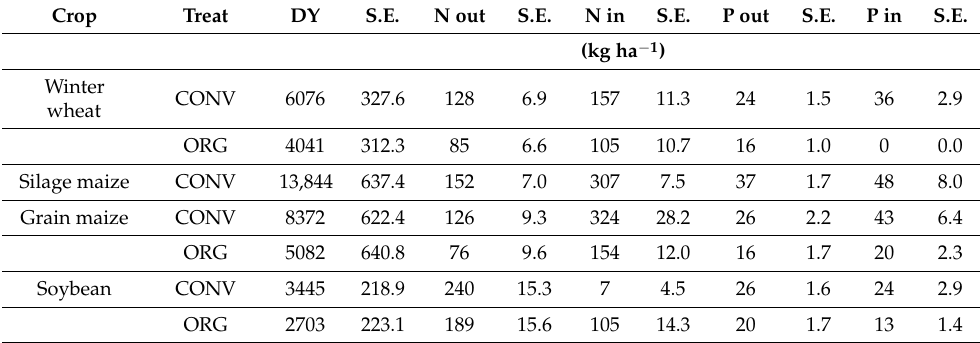
Table A2. Mean value of dry yield (DY), N output (N out), N input (N in), P output (P out), and P input (P in) according to crop and treatment (Treat) in real field conditions. CONV: conventional; ORG: organic; S.E.: standard error.